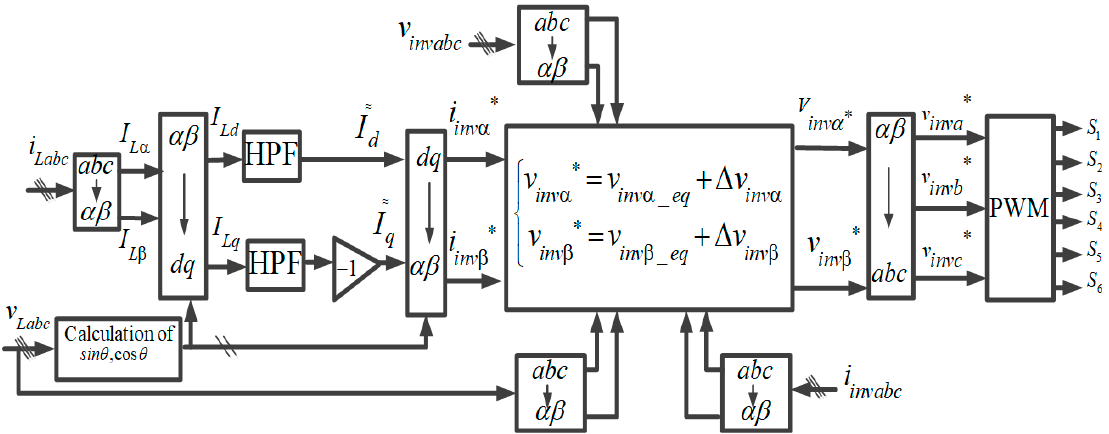
Figure 5. Single-phased d-q theory-based on SMC.